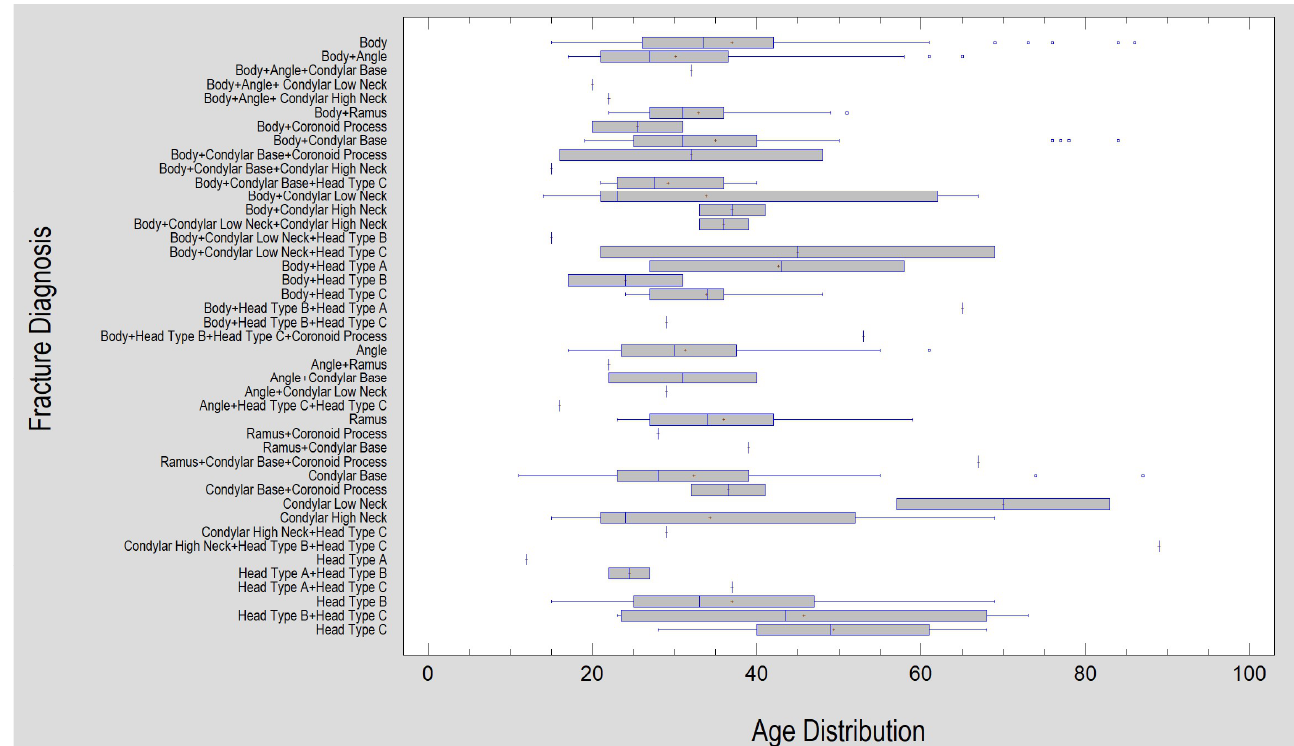
Figure 5. Fracture patterns observed in the presented material. In this overview, they refer to the age of the treated patients, but it is also important to note the rarity of certain fracture combinations (vertical lonely lines on the graph), e.g., fractures of the condylar process neck rarely co-occur with fractures of the mandibular body and angle. It is worth noting this and always remembering the importance of looking for another fracture of the condylar process, even when it seems that such a mandible fracture has never been observed together with a fracture of the condylar process of the mandible. Eighteen such peculiar combinations were